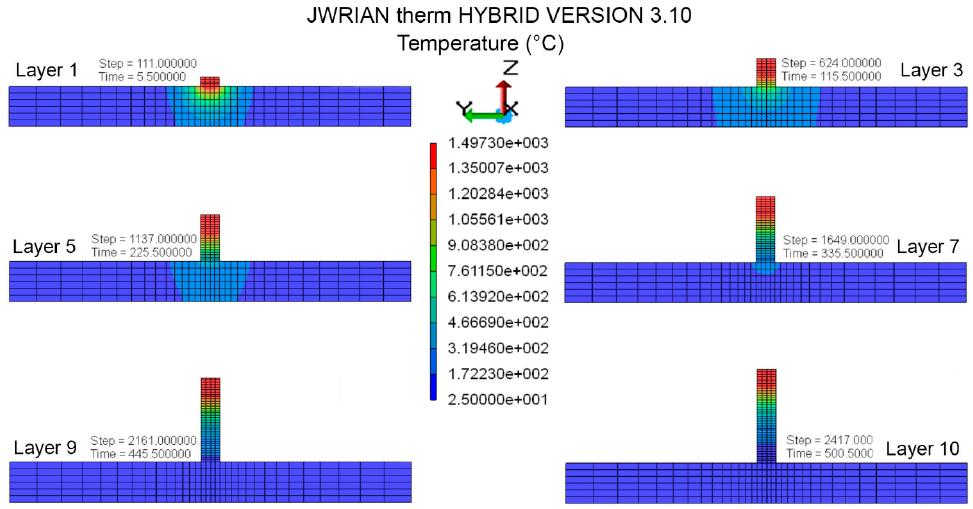
Figure 7. FEA transient temperature pro fi le in middle cross-section during layer-by-layer consoli-